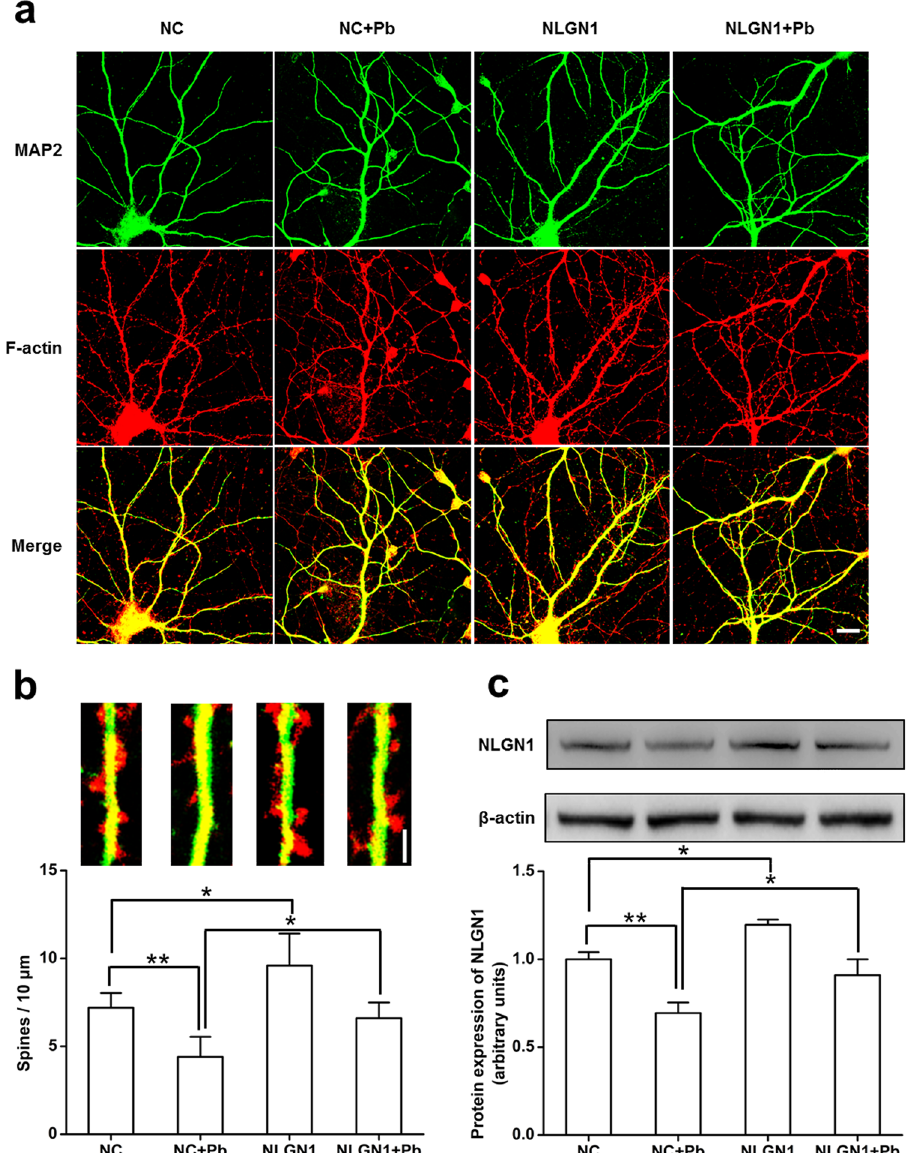
Figure 6. Effect of NLGN1 overexpression on dendritic spine density in hippocampal pyramidal neurons upon Pb treatment in vitro . ( a ) primary cultured neurons stained with MAP2 and F-actin, scale bar = 20 μ m. N = 16 neurons per group. ( b ) Top: from left to right, are NC, NC + Pb, NLGN1 and NLGN1 + Pb groups, respectively, scale bar = 5 μ m; bottom: statistical analysis of spine densities after Pb exposure. Data are representative of at least three independently performed experiments and expressed as mean ± SD of spines per 10 μ m for all groups, * p < 0.05, ** p < 0.01. ( c ) Up regulation of NLGN1 was detected via Western Blot. Overexpression of NLGN1 led to increased expression of NLGN1 protein in GLE rats. Data are representative of at least three independently performed experiments and expressed as mean ± SD, * p < 0.05, ** p <